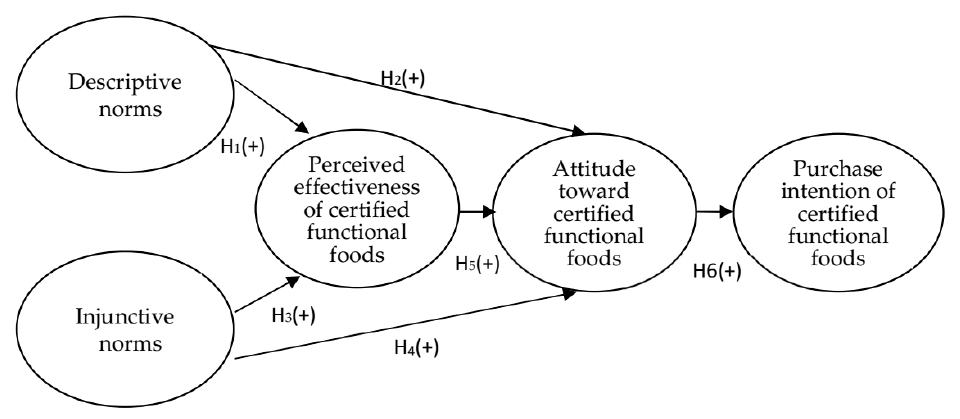
Figure 1. Research framework and results.